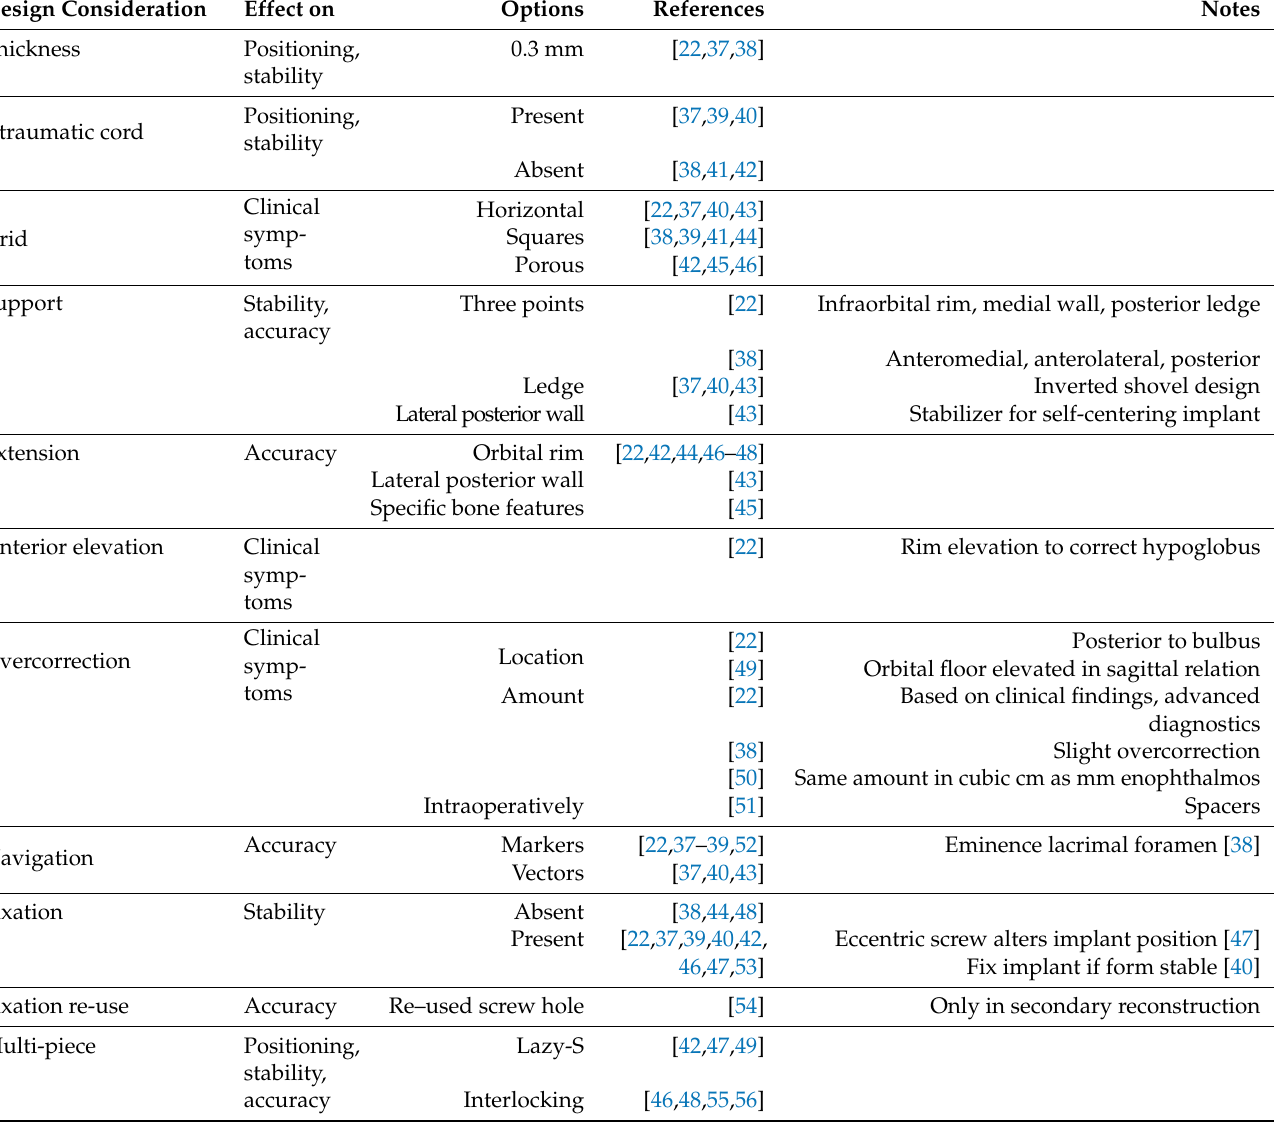
Table 1. List of different design considerations as reported in the